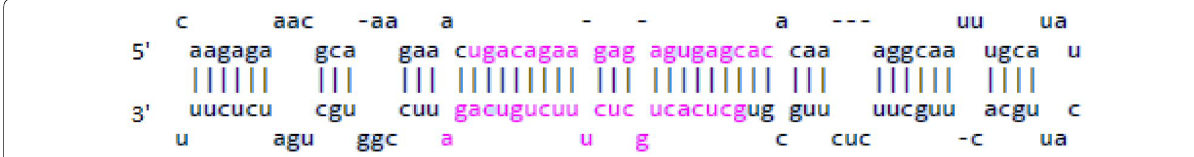
Fig. 3 A pre-miRNA molecule with the sequences of miRNA and miRNA* highlighted in pink. Notice that the highlighted part is displaced by two nucleotides relatively to the one above